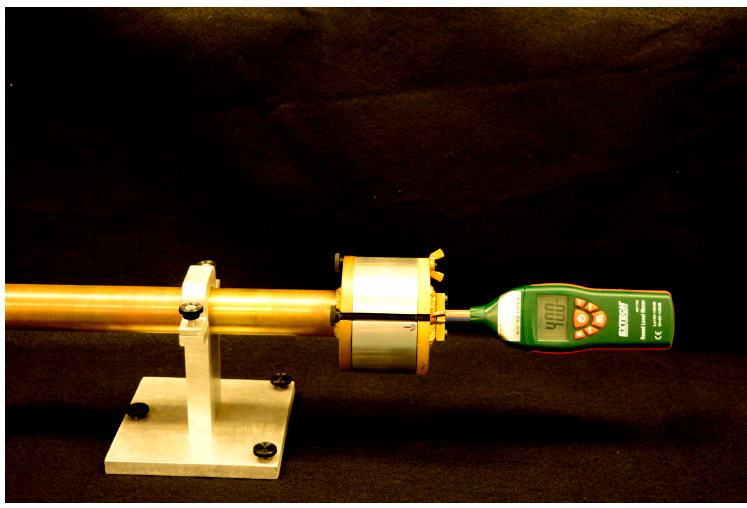
Figure 12. Simplified acoustic testing equipment setup that is enabled through the use of the SIM method.